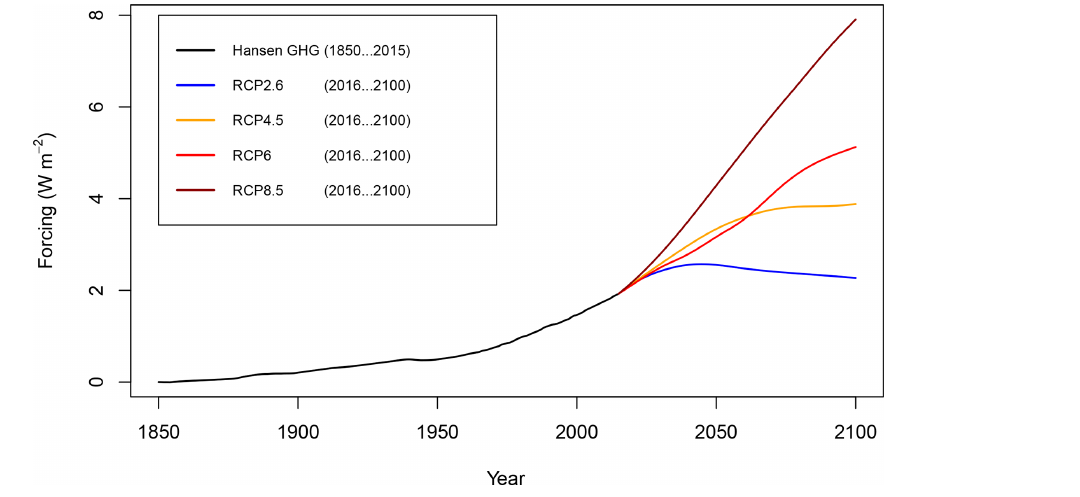
Figure 3. The greenhouse gas component of the Hansen forcing (black) followed by the RCP2.6 (blue), RCP4.5 (orange), RCP6 (red), and RCP8.5 (dark red) forcing scenarios.